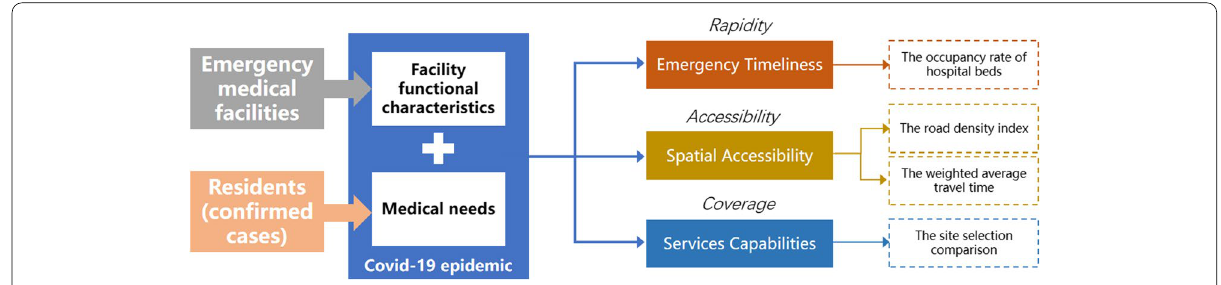
Fig. 2 The evaluation framework and indicators